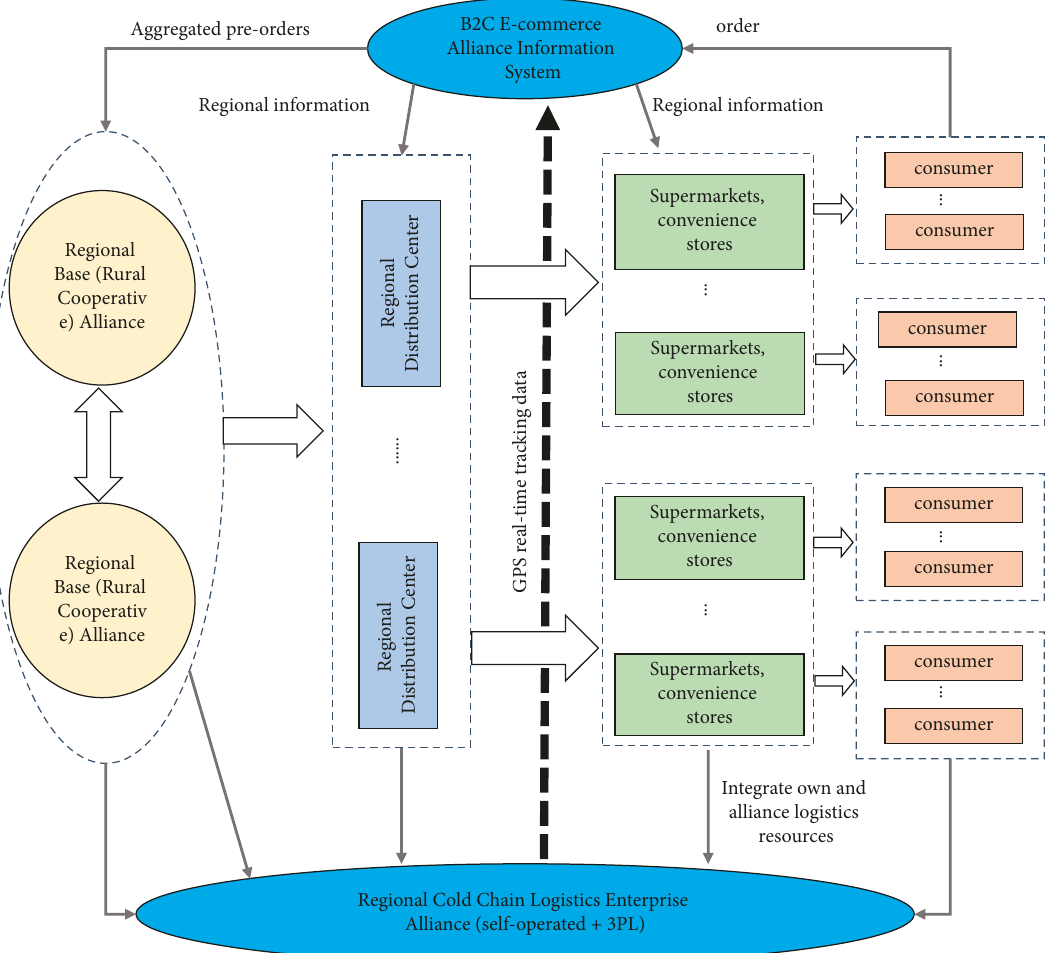
Figure 6: Codistribution mode of fresh food e-commerce cold chain based on the